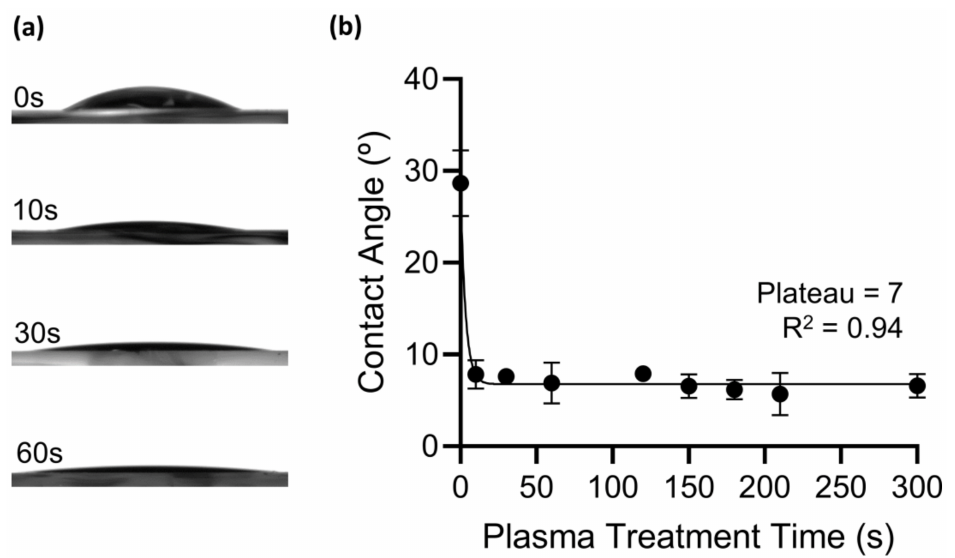
Figure 2. Hydrophilic properties of the Au-TiO 2 thin films. ( a ) Photographs of a water droplet and the ( b ) contact angle (in degrees) measured as a function of O 2 plasma treatment time in seconds (s) on the surface of Au-TiO 2 thin